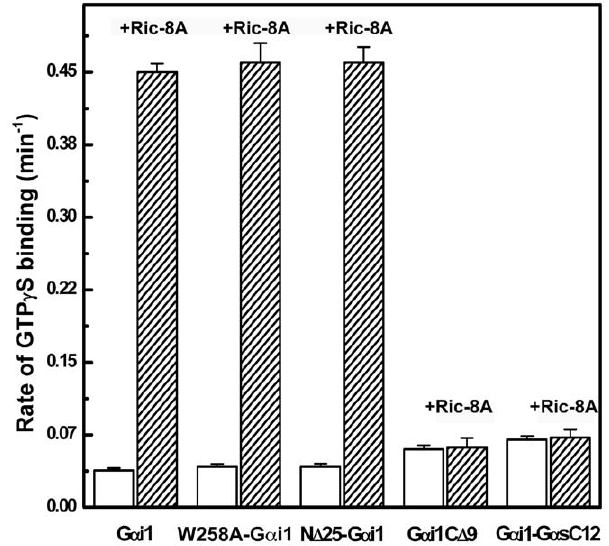
Figure 2. Intrinsic and Ric-8A-catalyzed GTP c S binding rates of the G a i1 proteins used in this study. Intrinsic and Ric-8A-catalyzed kinetics of binding of GTP c S to wild-type G a i1, W258A-G a i1, N D 25G a i1, G a iC D 9 and G a i1-G a sC12 were measured using a fluorescence binding assay [12,47]. 400 m l of protein (1 m M) in the GDP bound form was equilibrated for 10–15 min at 25 u C in a cuvette. A 10-fold excess of GTP c S was added and fluorescence at 340 nm upon excitation at 290 nm was monitored in the absence (open bars) or presence (filled bars) of Ric-8A (1 m M). Error bars represent + / 2 one standard deviation apparent first-order rate constants determined in three replicates.